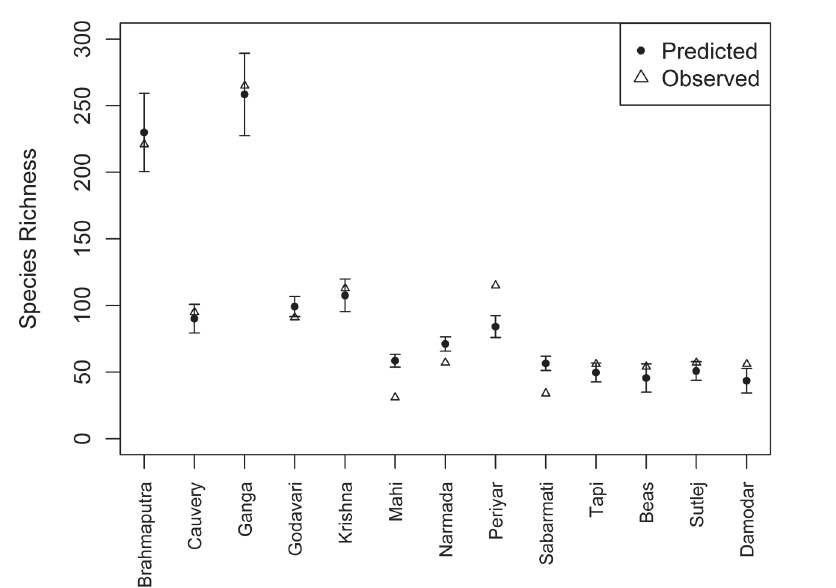
Fig. 5. The 95% confidence interval with predicted and observed values of fish species richness of each of the stud- ied Indian rivers